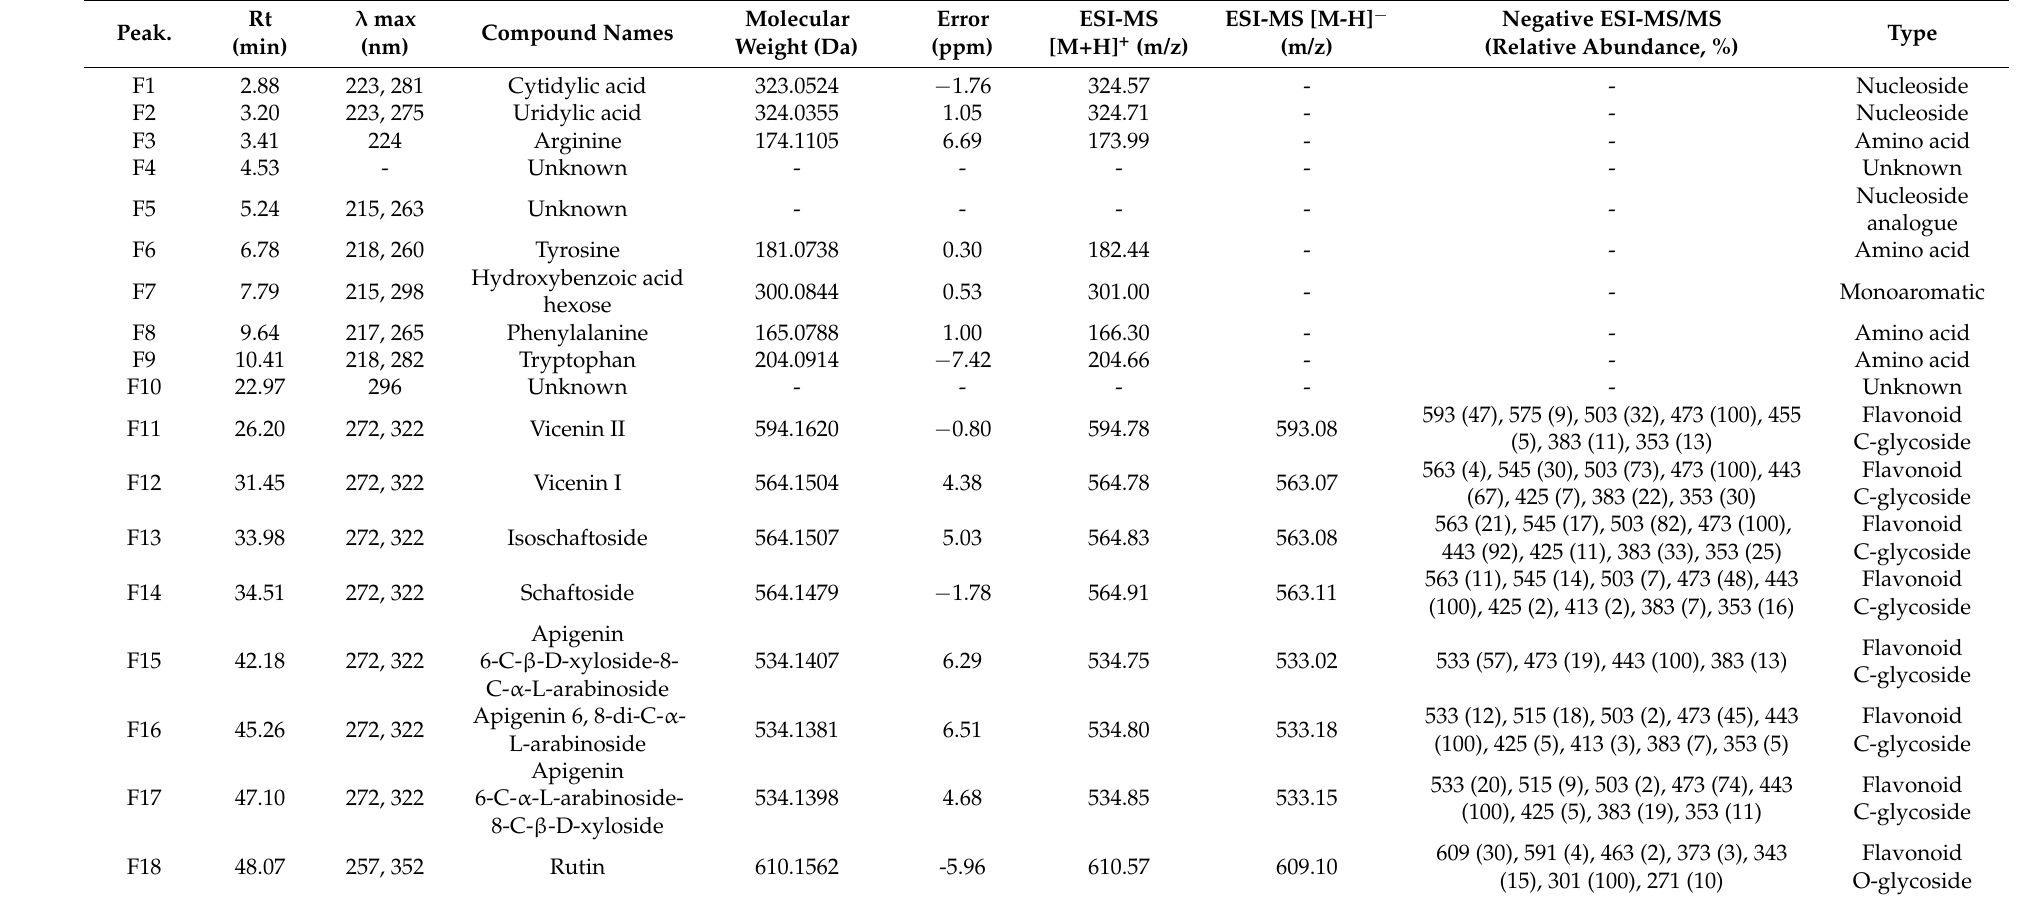
Table 2. Metabolites from Dendrobium catenatum leaves identified by HPLC-DAD/ESI-MS n .